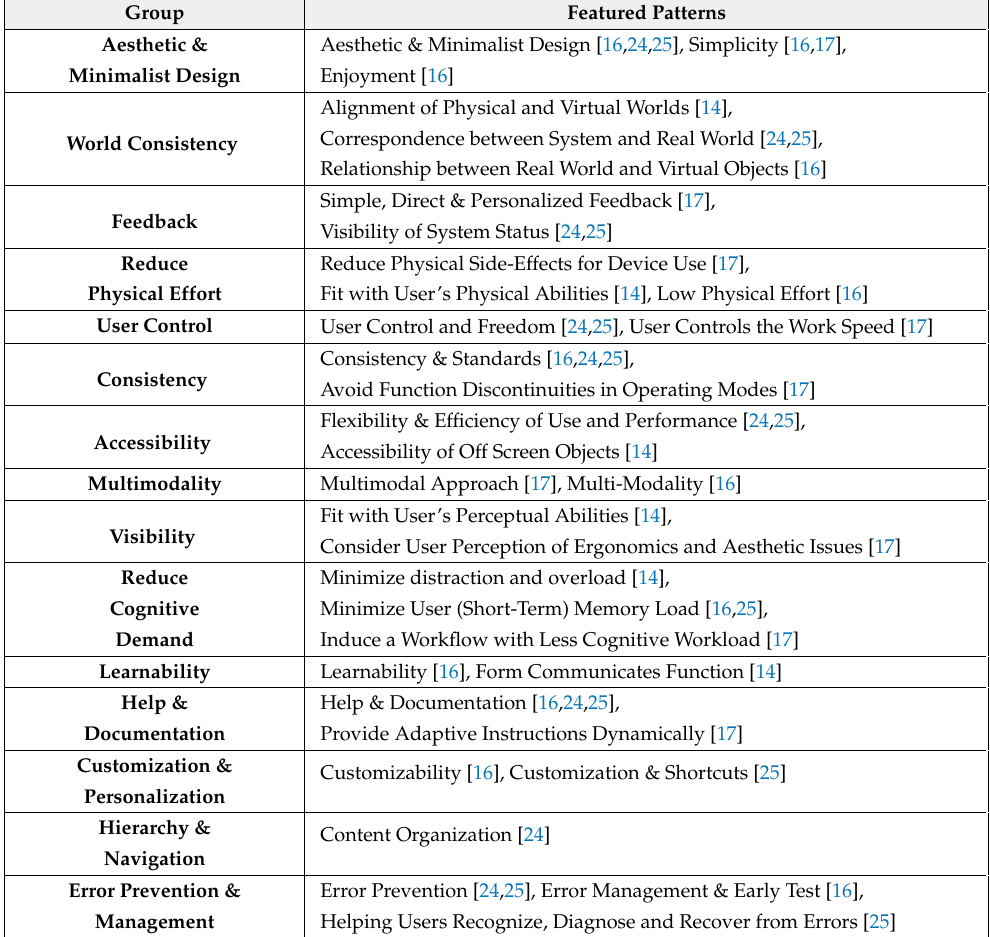
Table 3. Consolidated design